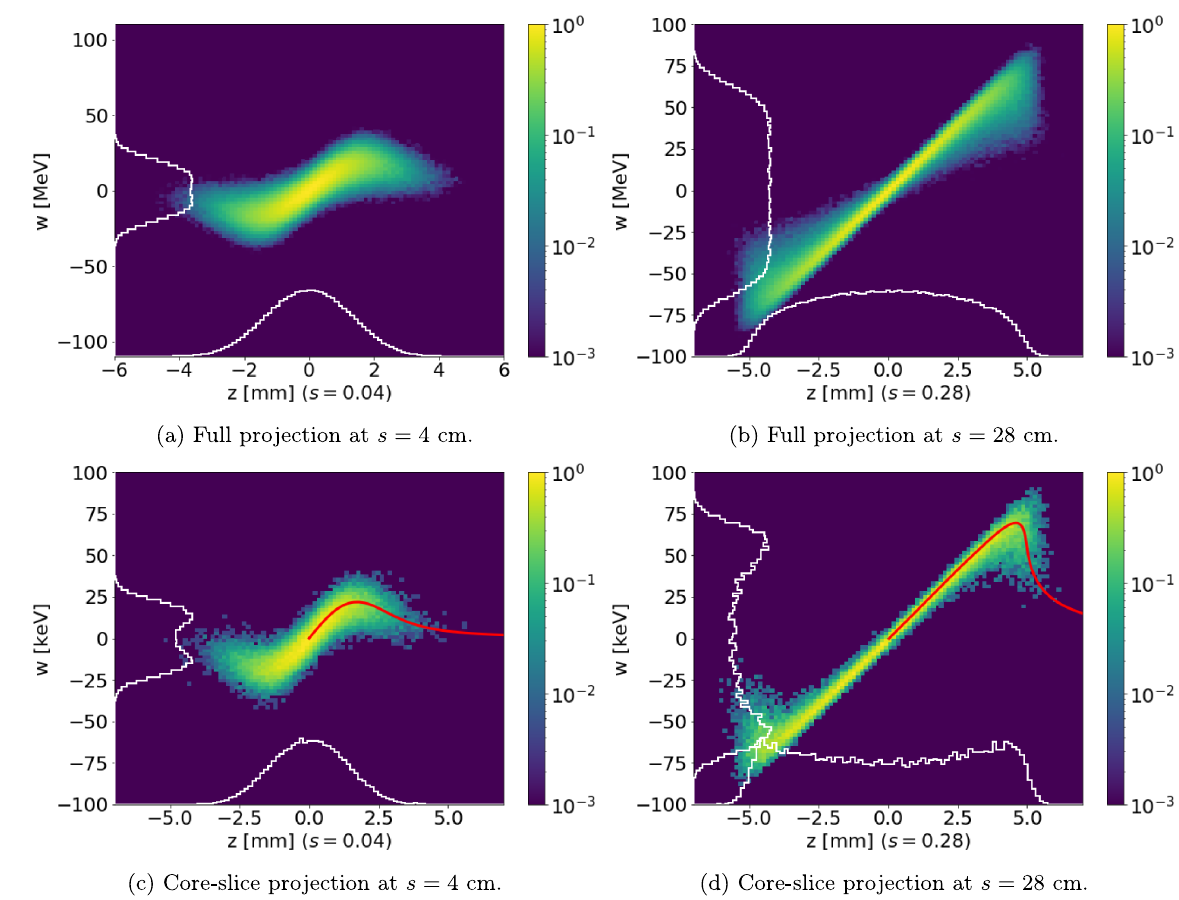
FIG. 4. Evolution of the 100 mA 6D Gaussian beam in longitudinal phase space. Frames (a) and (b) show the full projection at s ¼ 4 cm and s ¼ 28 cm. Frames (a) and (b) show a partial projection of the 10% 2D core slice in x and y at the same locations. The red line shows the evolution of a sequence of particles seeded along z , with initial x; x 0 ; y; y 0 ; w ¼ 0